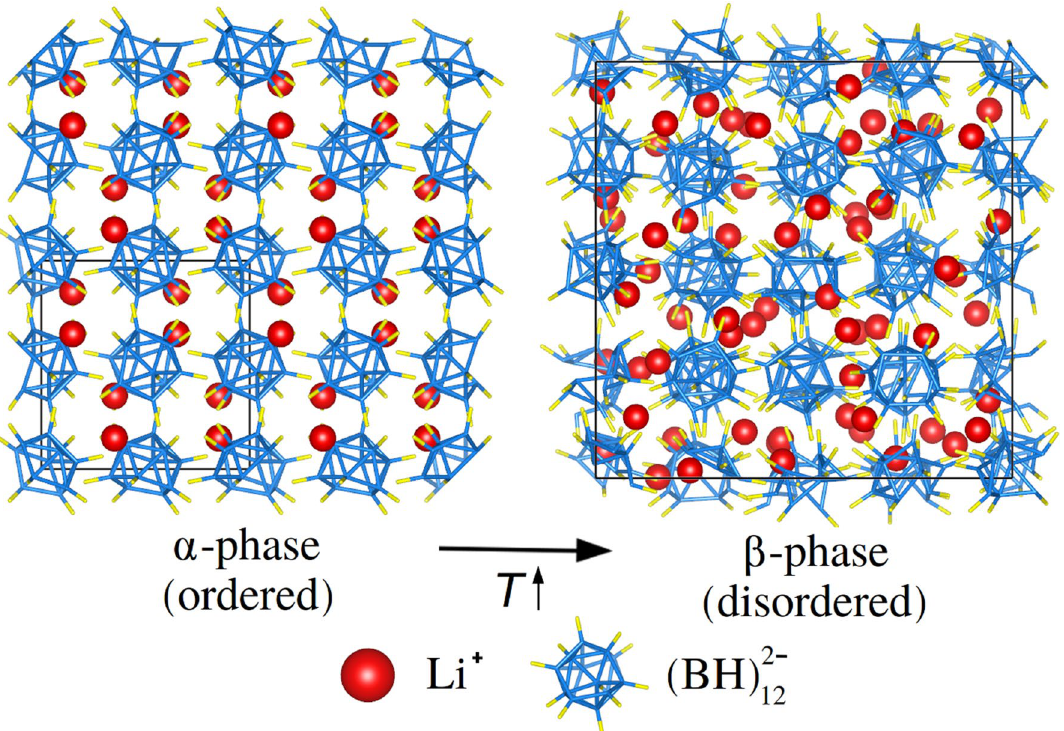
Figure 1. Low- T (ordered) and high- T (disordered) phases of bulk Li 2 B 12 H 12 . The low- T phase ( α ) presents cubic symmetry and space group Pa 3 30 . In the high- T phase ( β ), cubic symmetry is preserved but the Li + ions 2 are highly mobile and the (BH) − 12 icosahedra present reorientational disorder 32 . The T -induced α → β phase transition is an order–disorder isosymmetric transformation that is regarded as of first order 32 . Li, B, and H ions are represented with red, blue, and yellow colours,